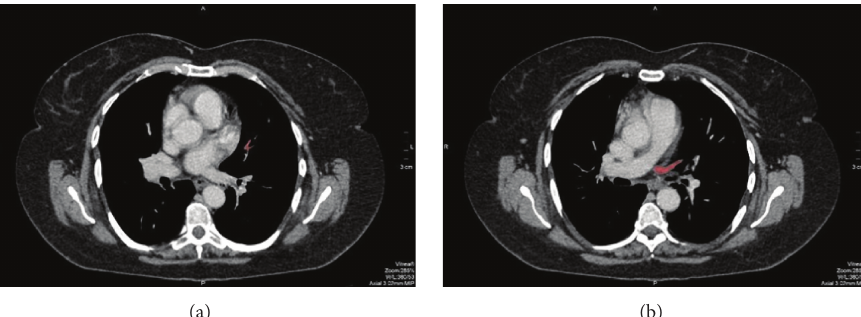
Figure 2: Axial sequential images: (a, b) the accessory lingular vein (red) presents orthotopic drainage to the left atrium.